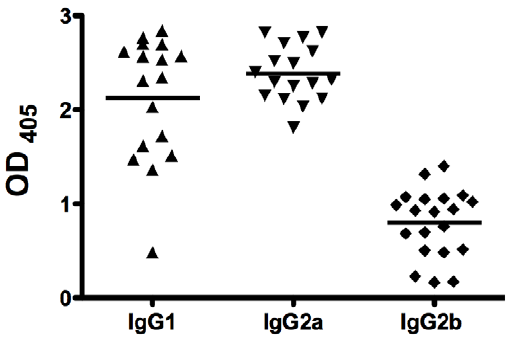
Figure 2. Pfs25 specific IgG isotype responses following Ad- MVA Pfs25 immunization. BALB/c mice were immunized with Ad- MVA Pfs25 as in figure 1a. Mice were immunized in two separate experiments and the data show pooled responses (n= 17–20). Individual isotype IgG responses against recombinant Pfs25 protein were measured by ELISA in the serum of mice taken at 2 weeks following final immunization. Individual and mean OD results are shown for samples measured at a dilution of 1 in 500. Positive (immune) and negative (non-immune) control sera were included in all assays. IgG3 was undetectable at this